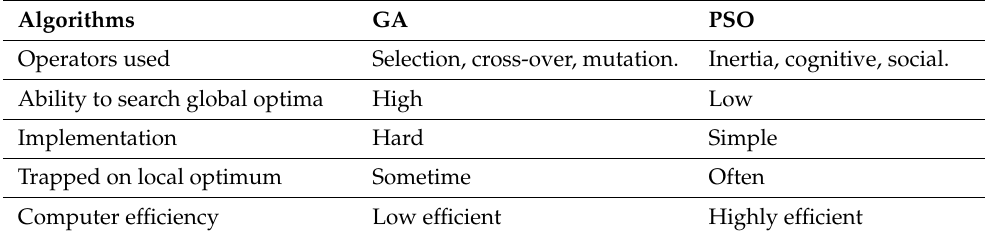
Table 2. Combination of GA-PSO techniques in WSNs.